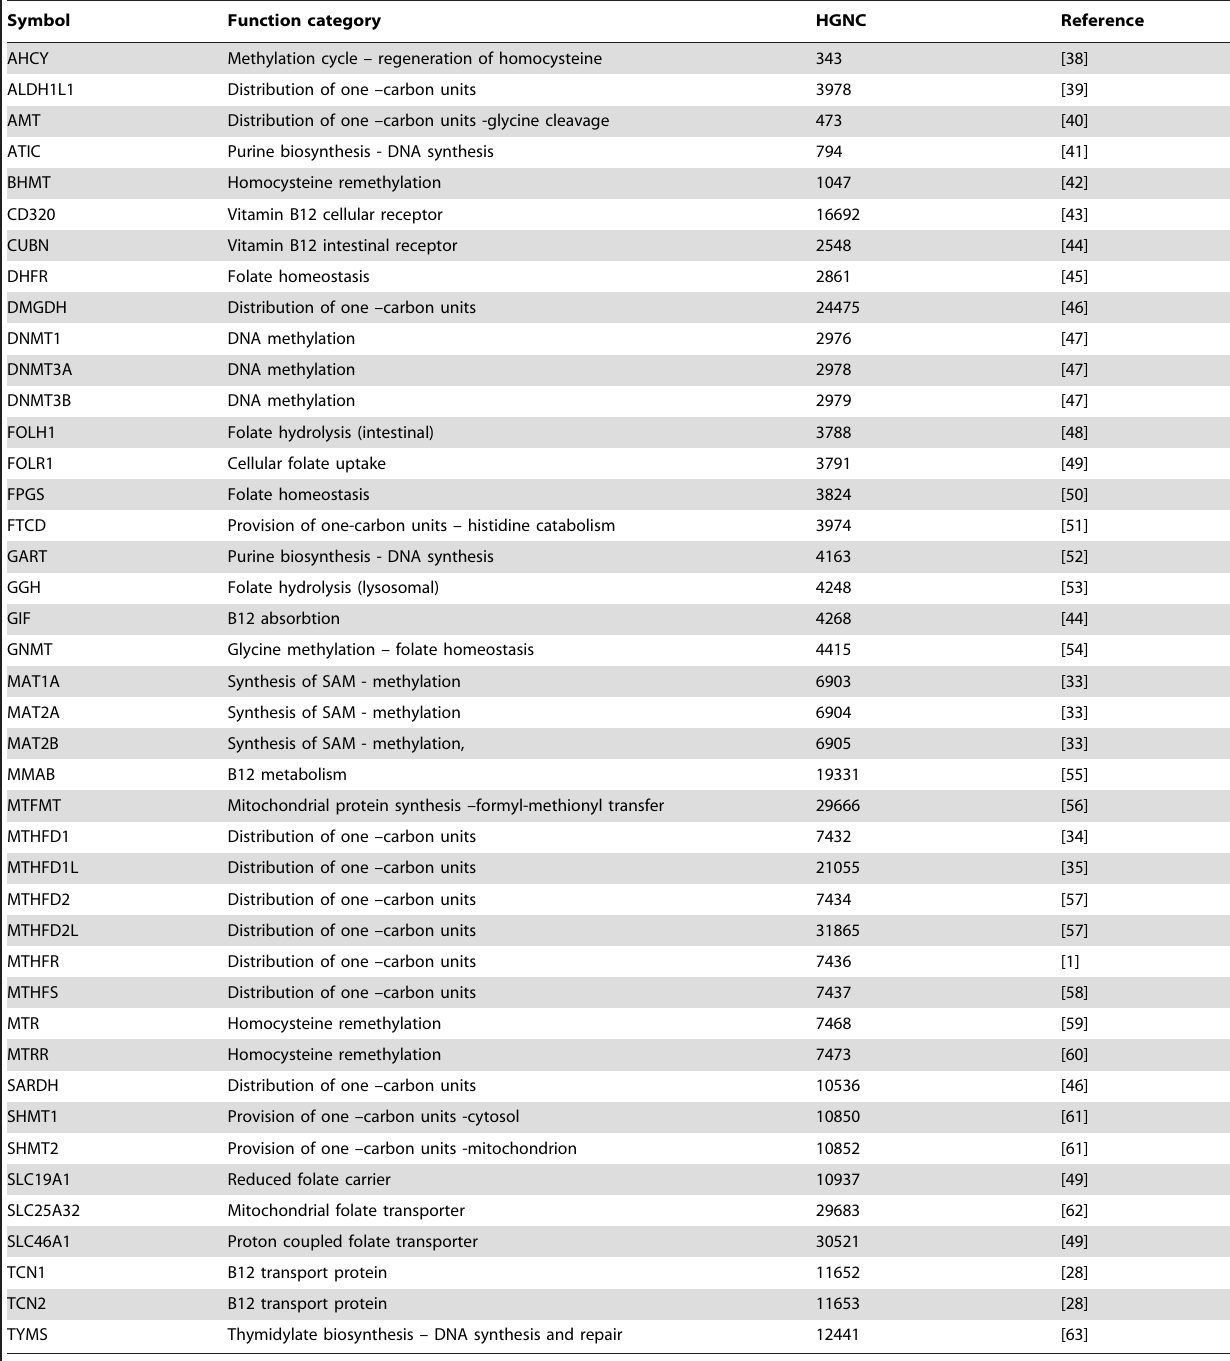
Table 1. Genes involved in one-carbon metabolism